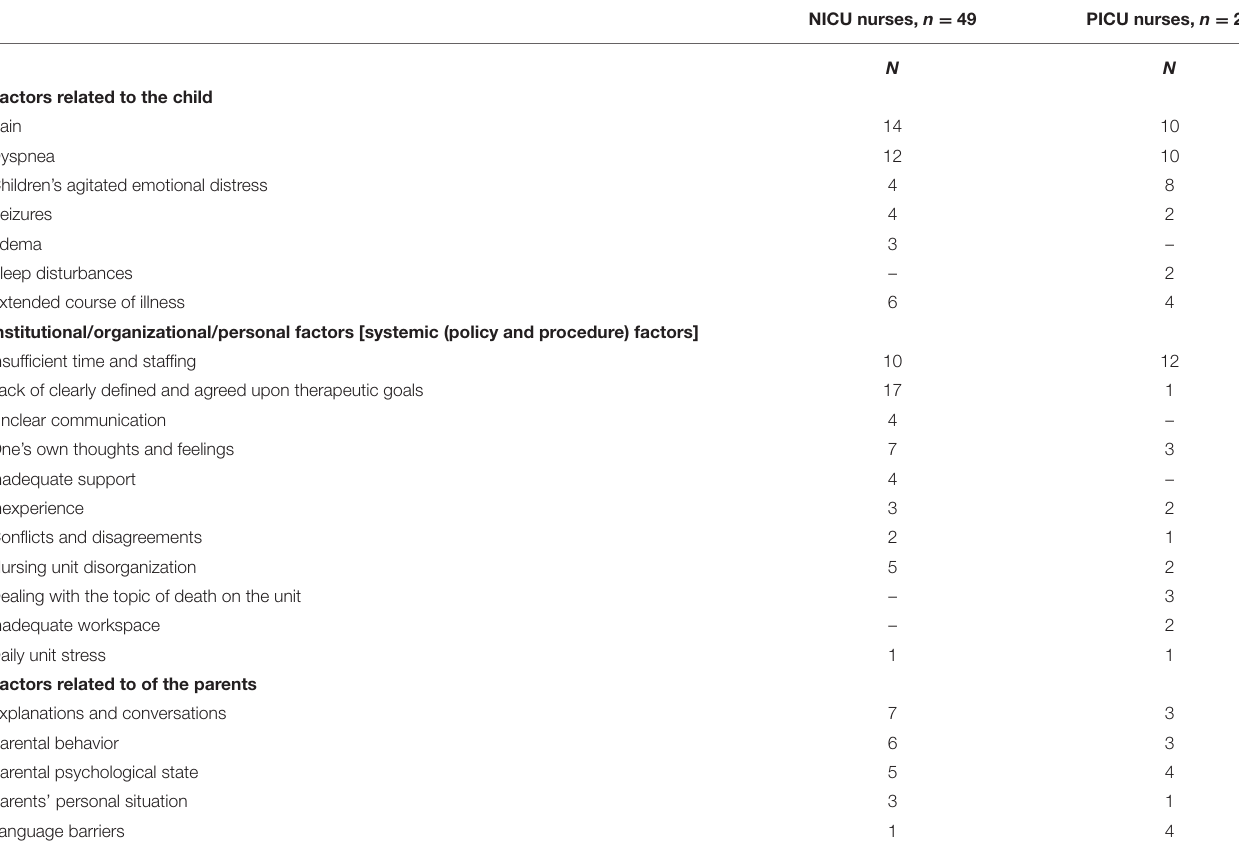
TABLE 2 | Self-reported most distressing sources of distress in end-of-life care situations by NICU and PICU